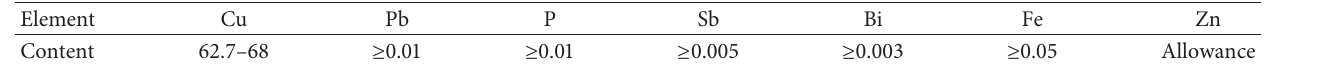
Table 2: Chemical composition of H65